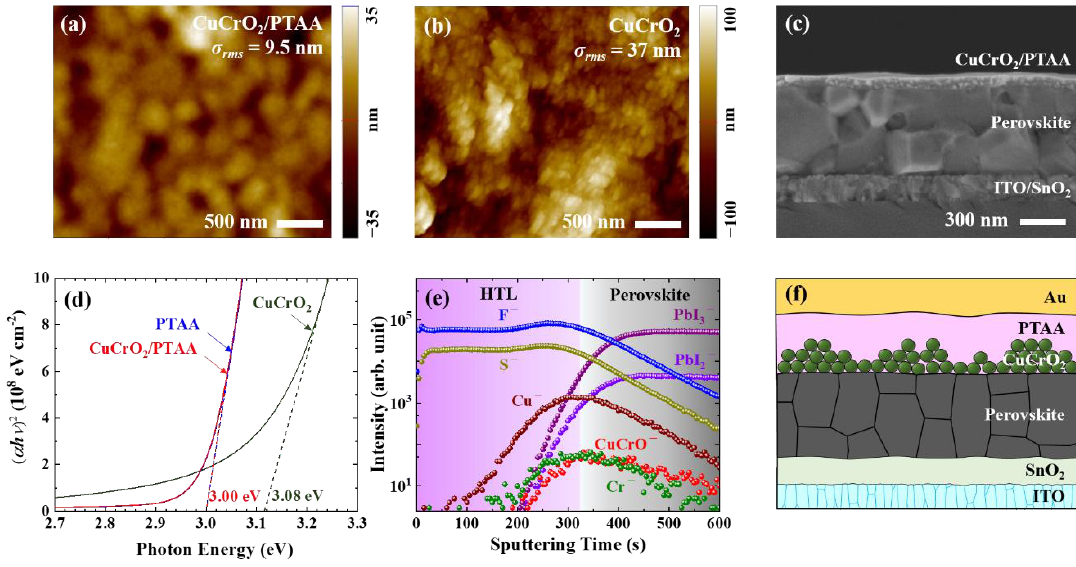
Figure 1. Morphological and structural analyses of CuCrO 2 /PTAA and CuCrO 2 hole transport layer (HTL): ( a,b ) Topography and root-mean-square (RMS) surface roughness of each HTL deposited on indium-doped tin oxide (ITO)/SnO 2 /perovskite, obtained by atomic force microscope (AFM); ( c ) Cross-sectional scanning electron microscopy (SEM) image of ITO/SnO 2 /perovskite/HTL film; ( d ) UV-visible absorption spectra and the optical bandgap energy of each HTL deposited on a glass substrate; ( e ) Time-of-flight secondary ion mass spectrometry (TOF-SIMS) depth profile of the ITO/SnO 2 /perovskite/CuCrO 2 /PTAA film; ( f ) Schematic illustration of the device architecture with CuCrO 2 /PTAA HTL. Light is incident on an ITO side during the solar cell operation.